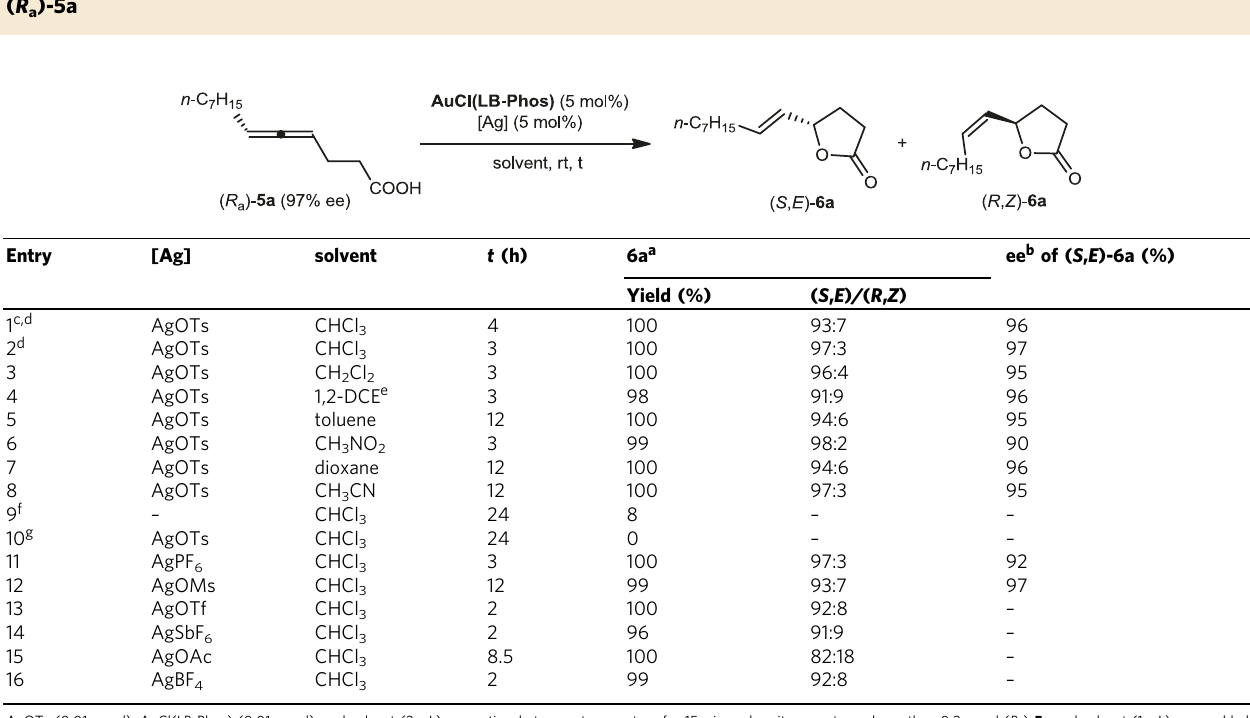
Table 1 Optimization of the reaction conditions for AuCl(LB-Phos)-catalyzed stereoselective cyclization of 4,5-allenoic acid ( R a